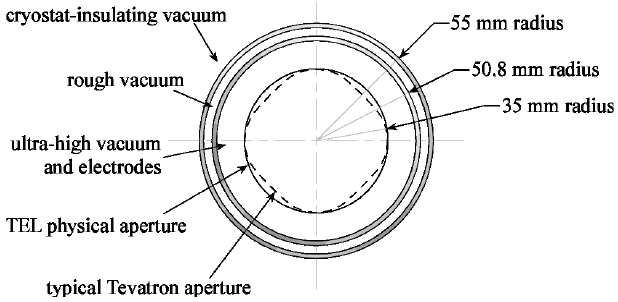
FIG. 20. Cross section of the TEL beam pipe.